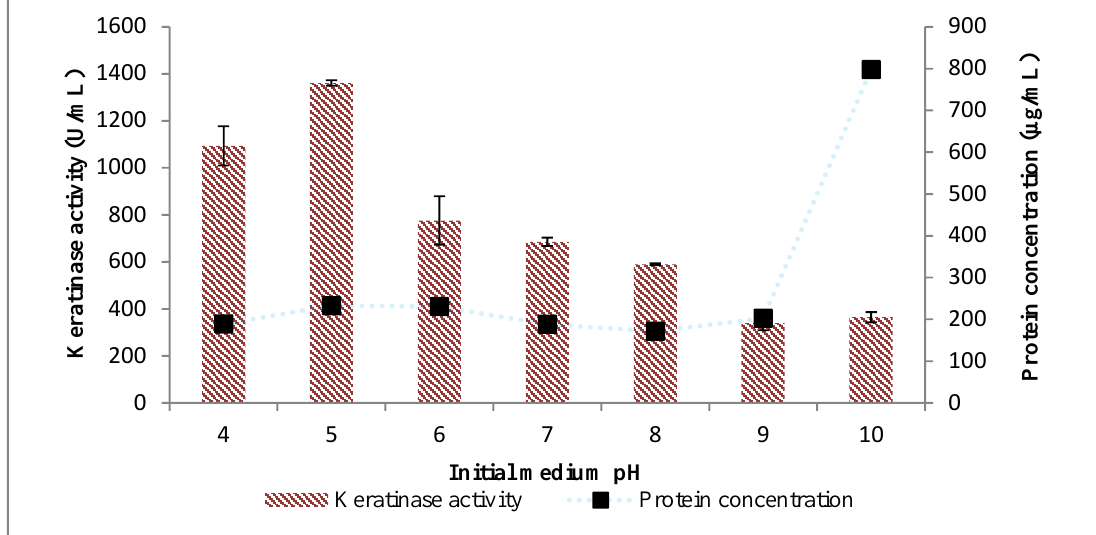
Figure 2. Effect of initial cultivation pH on keratinase activity by Bacillus sp. FPF-1. Figure 2. E ff ect of initial cultivation pH on keratinase activity by Bacillus sp.